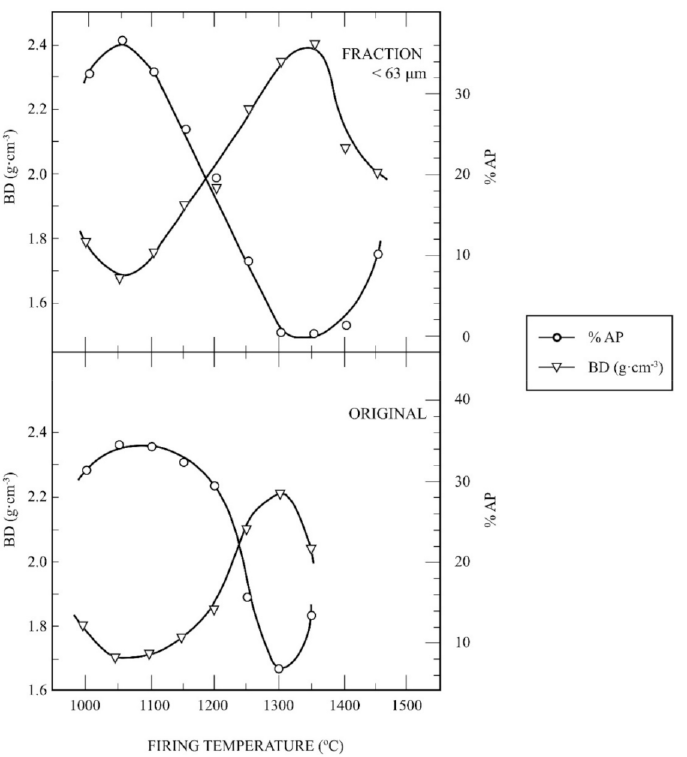
Figure 9. Thermal behaviour of the raw kaolin sample (labelled as ORIGINAL) and the fraction under 63 µ m: plot of the variation of bulk density (BD) and open porosity (OP) as a function of firing